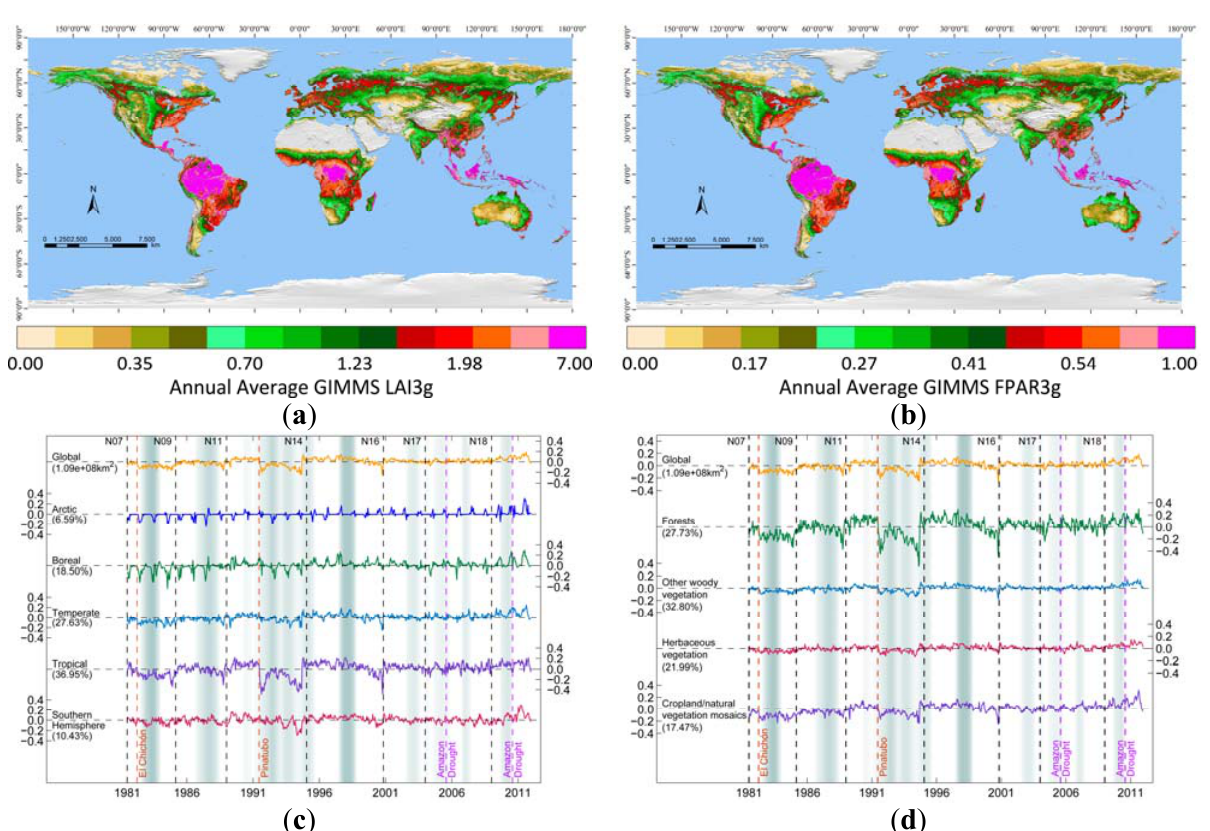
Figure 1. Leaf Area Index (LAI)3g and Fraction of Photosynthetically Active Radiation (FPAR)3g products. ( a ) Thirty year average annual mean LAI3g. ( b ) Thirty year average annual mean FPAR3g. ( c ) Time series of LAI3g anomalies for different latitudinal bands. ( d ) Time series of LAI3g anomalies for different vegetation types. The background shading in (c) and (d) shows the occurrence and intensity of EI Niño-Southern Oscillation (ENSO) events as defined by the Multivariate ENSO Index. The black dashed lines indicate transition times for the various National Oceanic and Atmospheric Administration (NOAA) satellites (N07 to N18). The two major volcanic eruptions (El Chichón and Mount Pinatubo) and the two recent Amazonian droughts are depicted by the orange and purple dashed lines,